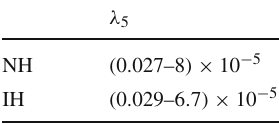
Table 4 The numerical values of the parameters chosen for generat- ing correct Fermion DM relic and baryon asymmetry. We denote it as benchmark point 2 (BP2). The fraction ω is to ensure to get the correct baryonic asymmetry. For Normal (Inverted) Hierarchy ω = 0 . 85 ( 0 . 45 )